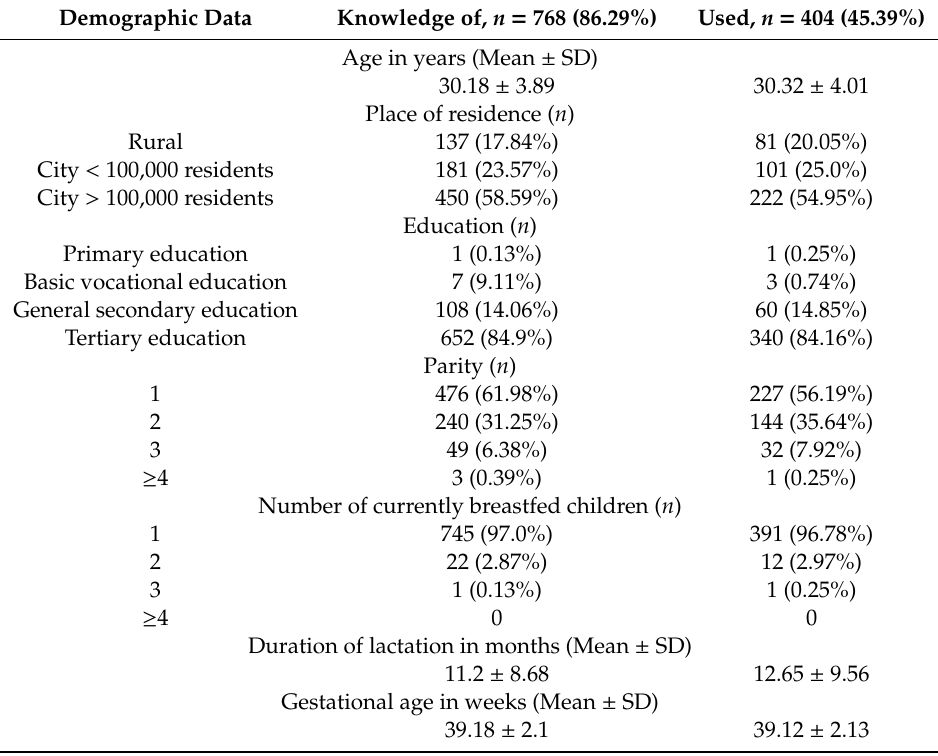
Table 1. Characteristics of the population of women who had contact with information about use of human milk for mucous membranes (“knowledge of”) or used it in practice